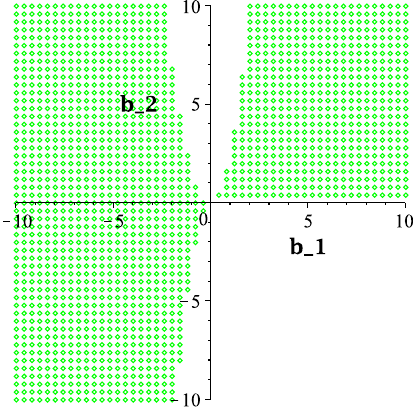
Figure 12 . Ghost-free parameter space: an illustrative plot of ghost-free parameters for D = 5 for the Einstein branch with ~ b 0 = 0 : 5 ; ~ (cid:21) = 0 : 2 and ~ (cid:22) = 0 : 05 for a non-zero, constant scalar (cid:12)eld background. The parameters indicated by green dots in the above plot correspond to ghost-free AdS vacua with non-zero constant scalar (cid:12)eld under the constraints imposed on the couplings by the existence of spherical black holes [see eq.